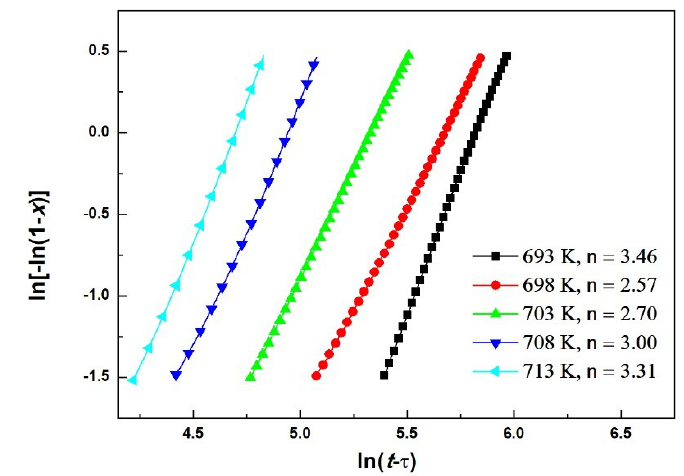
Figure 9. JMA (Johnson–Mehl–Avrami) plots of crystallization at different temperatures for the W particles/Zr 41.2 Ti 13.8 Cu 12.5 Ni 10 Be 22.5 metallic glass matrix composite.